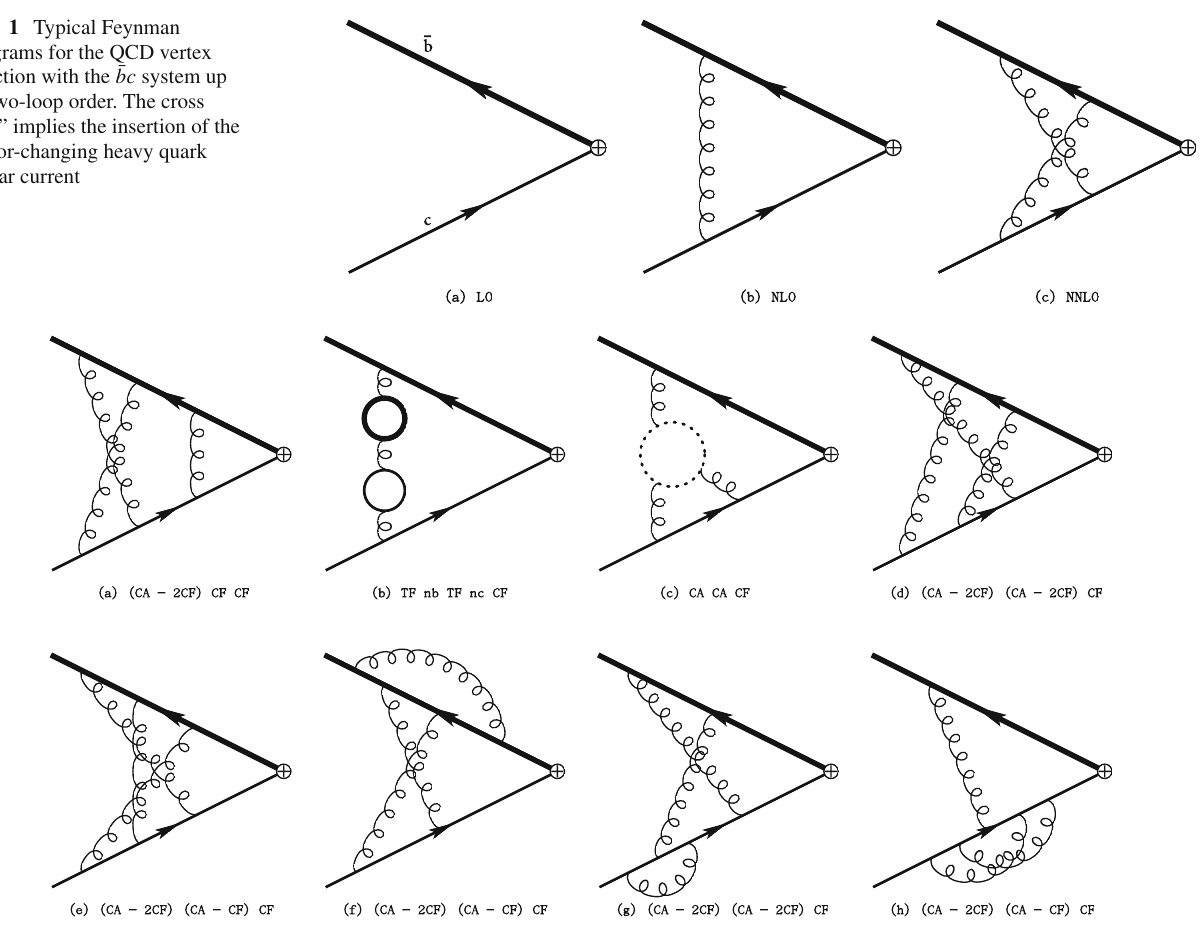
Fig. 2 Typical Feynman diagrams labelled with the corresponding color factor for the QCD vertex function with the flavor-changing heavy quark scalar current at three-loop order. The cross “